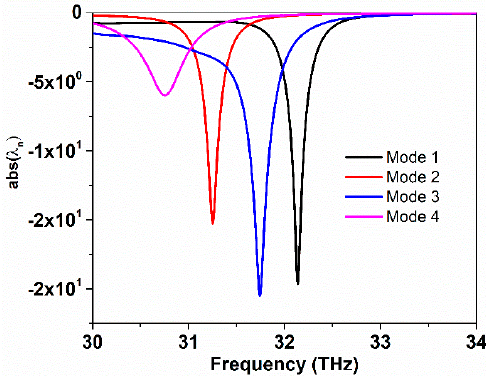
Figure 10. Resonance frequency response with respect to four different transverse magnetic (TM) Characteristic modes.